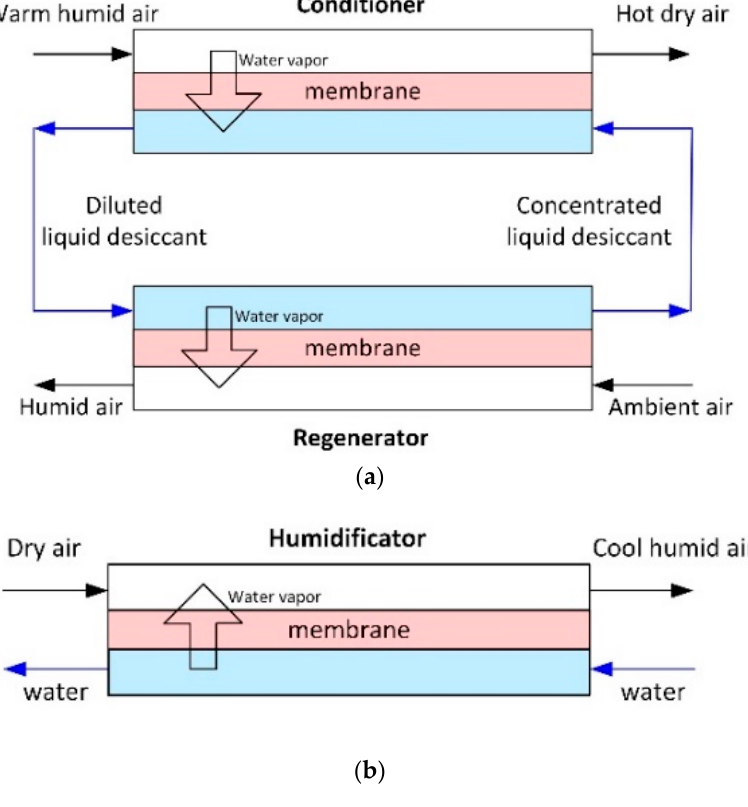
Figure 9. Membrane contactors for air humidity control: ( a ) Membrane air dehumidification; and, ( b ) Evaporative cooling/membrane humidification (adapted from [125]).